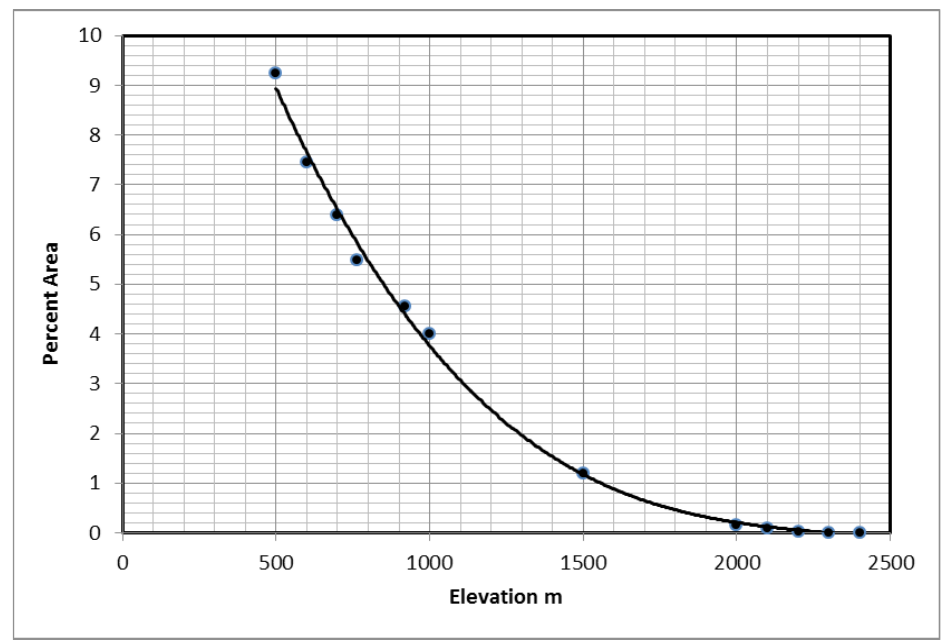
Figure 2: Percentage area of the island above selected